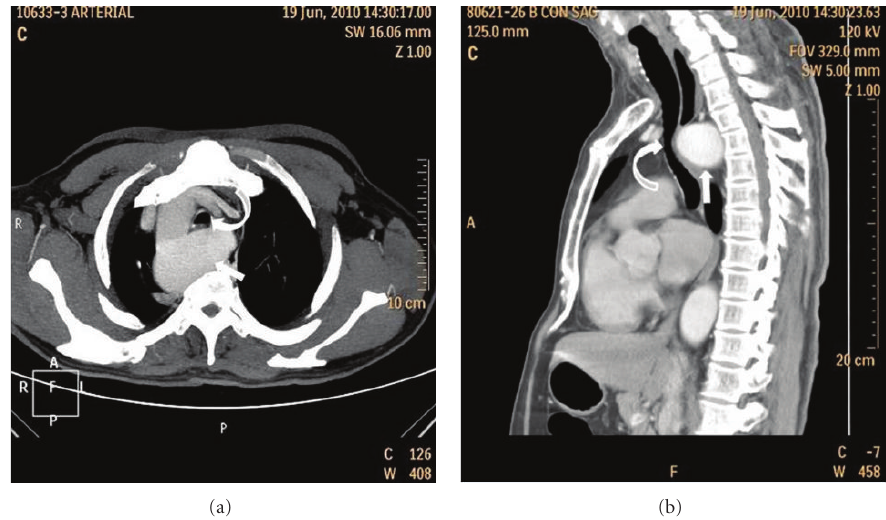
Figure 3: Contrast-enhanced computerized tomogram of thorax demonstrating trachea (curved solid arrow) narrowed between the arch of the aorta and the Kommerell’s diverticulum